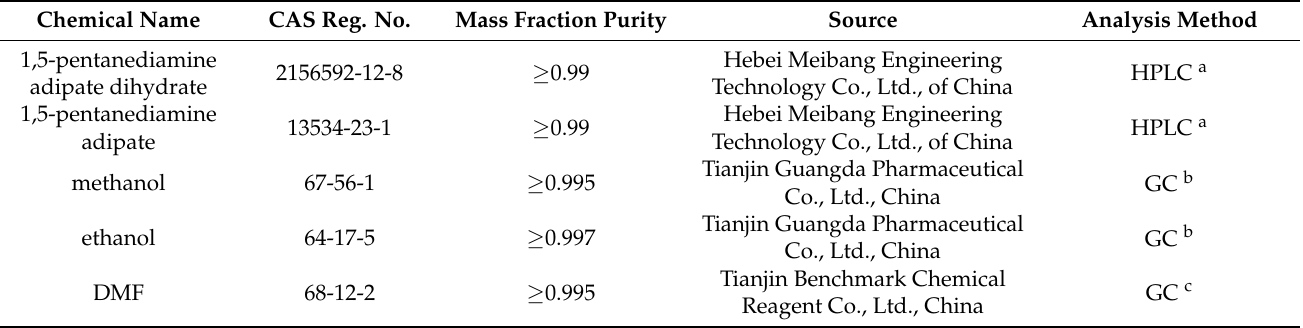
Table 1. Sources and mass fraction purity of